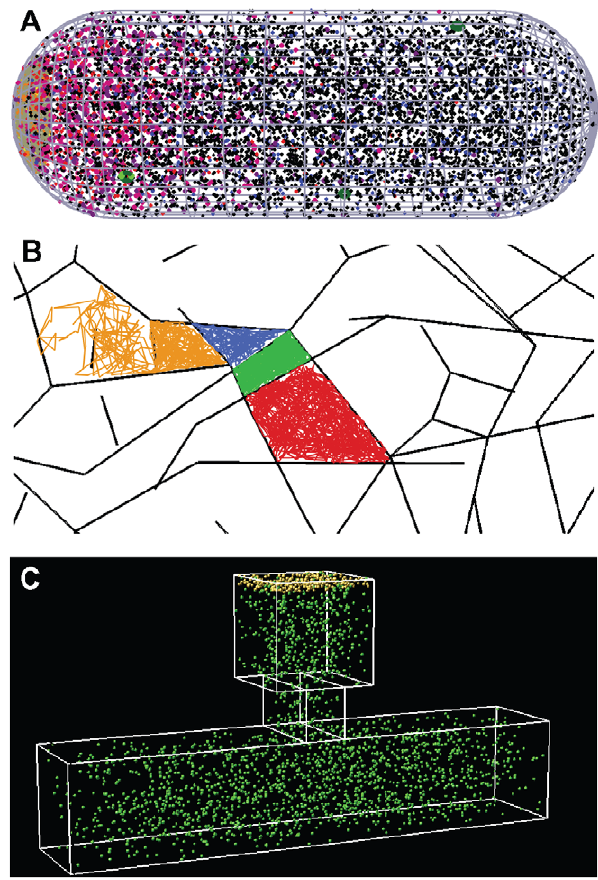
Figure 1. Example Smoldyn models. (A) Model of Escherichia coli chemotaxis, adapted from work by Lipkow and Odde [29]. Receptors are clustered at the left cell pole, unphosphorylated CheY messenger proteins are shown in black and phosphorylated CheY are in red. This simulation showed that the combination of a spatially segregated kinase-phosphatase system and phosphorylation-dependent diffusion coefficients can create stable protein gradients. (B) Simulated track of a diffusing lipid molecule, which is on a membrane that is divided into ‘‘corrals’’ by underlying actin filaments, shown with black lines. The track is shown in red, then green, blue, and yellow to illustrate that lipids tend to fully explore individual corrals before hopping to adjacent corrals. Actin data are from Morone et al. [74]. (C) Model of a dendritic spine, showing GFP-tagged calcium calmodulin dependent kinase II proteins (CaMKII) in green and molecules of the postsynaptic density at the spine tip in yellow, adapted from work by Khan et al. [26]. The authors used these simulations to analyze fluorescence microscopy data and to investigate CaMKII sequestration upon synaptic excitation.